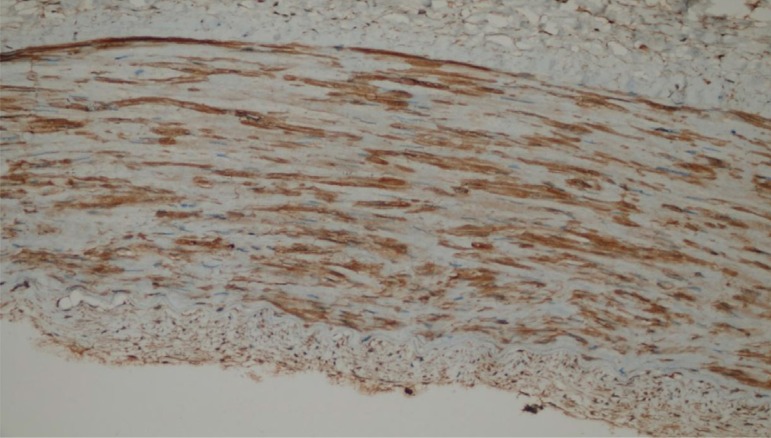
Endothelial nitric oxide synthetase (eNOS) of patient no. 17 (in the electrocautery group) ++ endothelial damage (eNOS immunohistochemical staining of the transverse section taken from the radial artery sample) (eNOS immunoreactivity in endothelial cells ++) (40×).